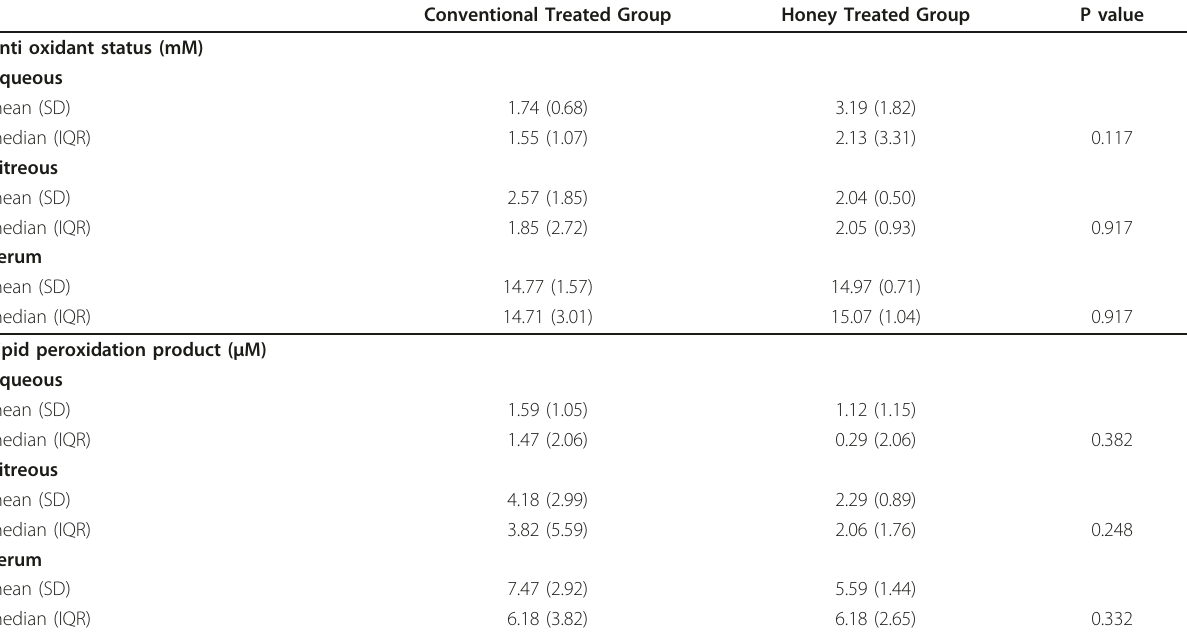
Table 4 Level of anti oxidant status and lipid peroxidation product in alkali chemical injury on rabbit ’ s cornea between conventional treated and honey treated groups Conventional Treated Group Honey Treated